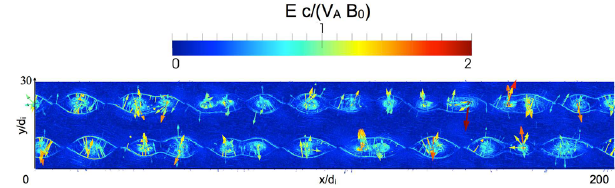
Fig. 6. Quiver plot and contour plot of the electric field, normalized to the reconnection electric field V A B 0 /c , at time (cid:127) ci t = 18 . 62. The electric field is mainly in-plane and is localized around and inside the magnetic islands.